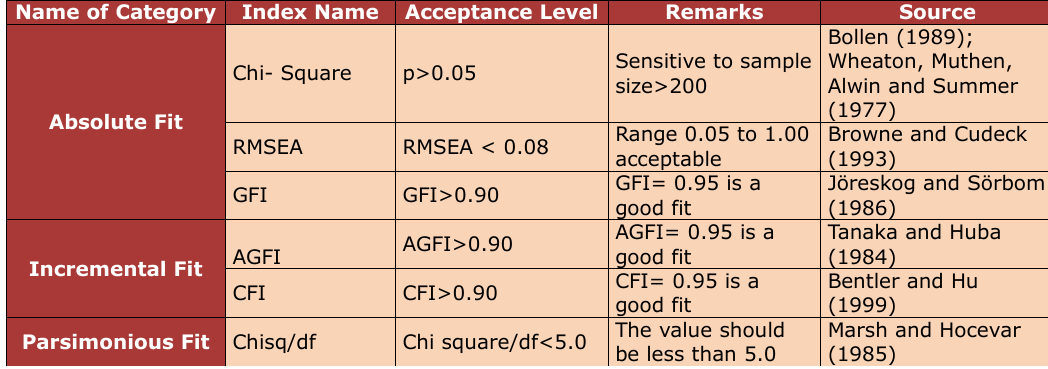
Table 2. Level of acceptance to test the fitness of the individual constructs